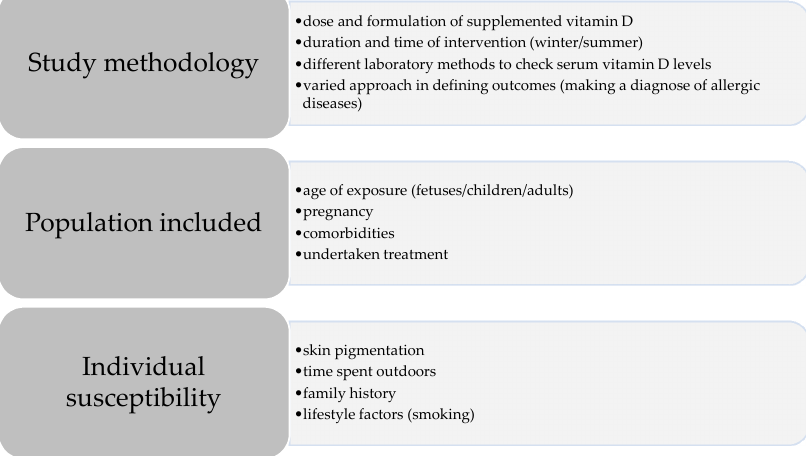
Figure 2. Factors contributing to variability of study findings.